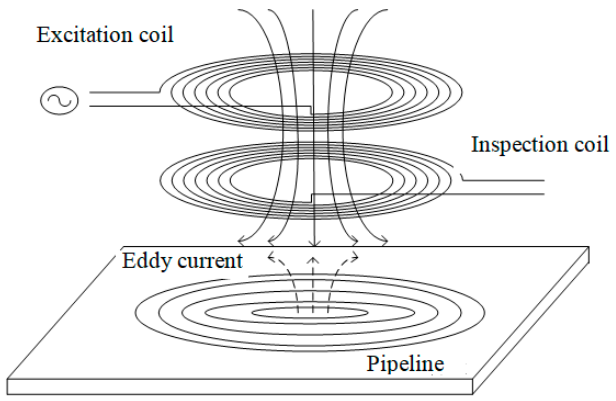
Figure 4. Principles of electromagnetic eddy current inspection.